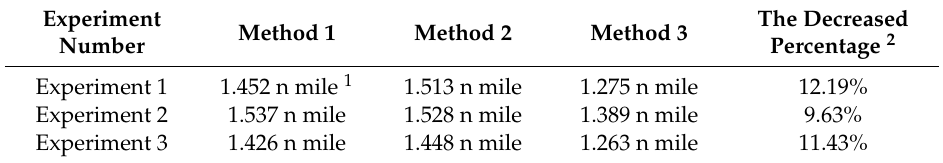
Table 6. The maximum position errors of field experiment.